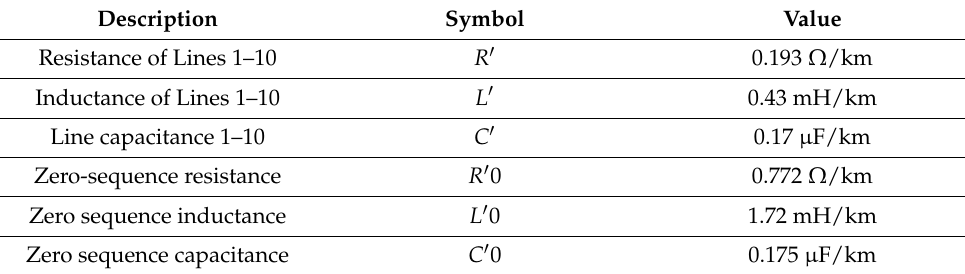
Table 1. Distribution line